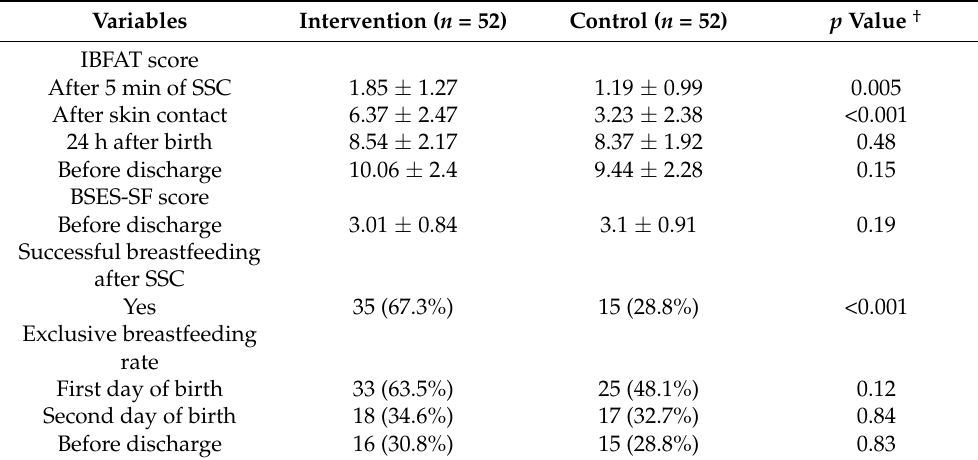
Table 3. Assessment of newborn sucking ability, breastfeeding self-efficacy, and exclusive breast- feeding rate.